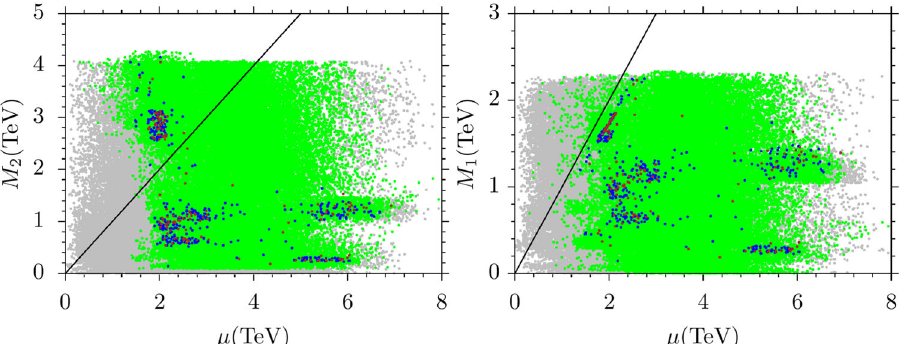
Fig. 4 Plots in the M 2 − μ and M 1 − μ planes. The color coding is the same as in Fig. 2 ˜ χ ± → q ¯ q (cid:3) ˜ χ 0 , as is classified in Signal 3. The M 1 − μ 1 1